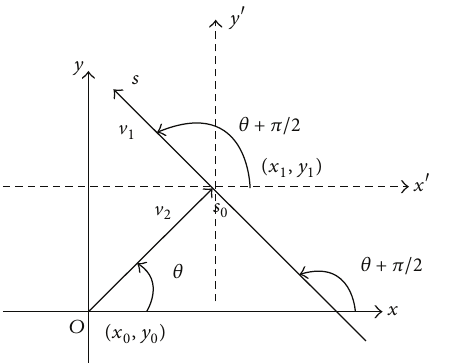
Figure 8: Schematic diagram in which 𝑠 is assumed as direction of nonadiabatic coupling